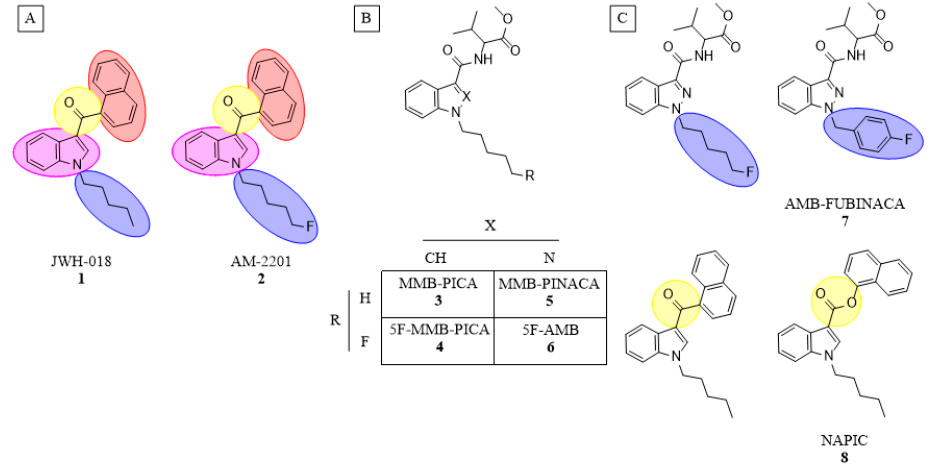
Figure 1. Relevant SCRA species for this study. ( A ) General SCRA structure containing a head (red), linker (yellow), core (pink) and tail (blue) subregion. ( B ) Valine-like head SCRAs detailing minor changes within an SCRA class. ( C ) Other common structural variations in tail and core subregions.